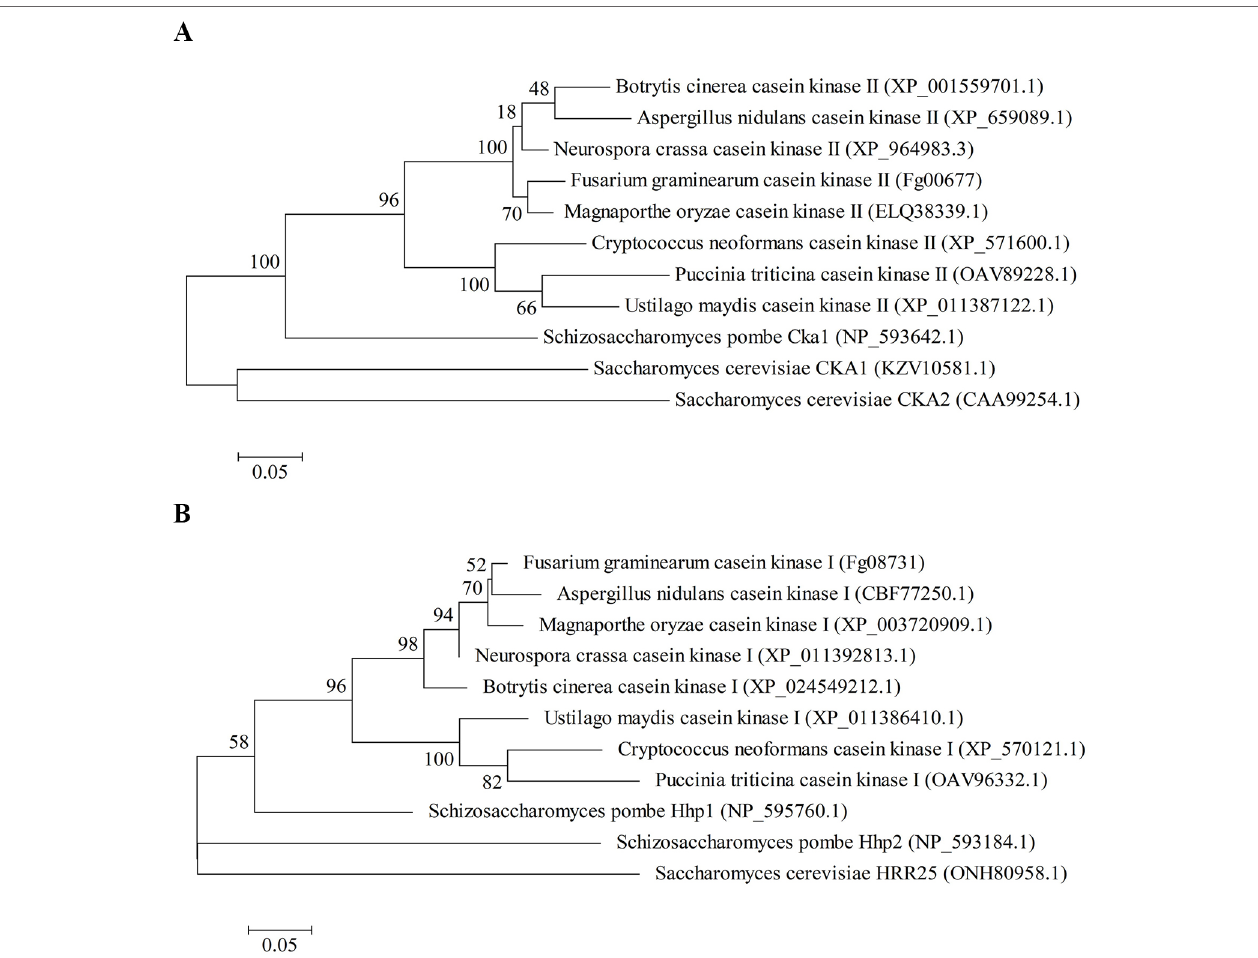
FIGURE 1 | Phylogenetic analysis of Fg00677 (a) and Fg08731 (B) with their homologs in other fungal species. Phylogenetic analysis was carried out with the MEGA5 software by the maximum likelihood tree-building methods.